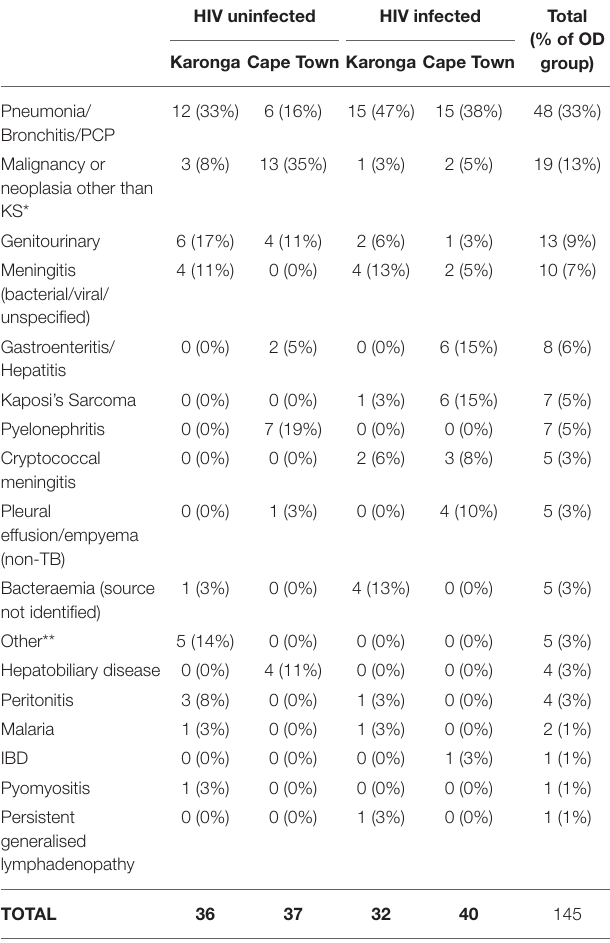
TABLE 2 | Major clinical diagnoses in the Other Diseases groups of the sample of the ILULU-TB cohort that was selected for this